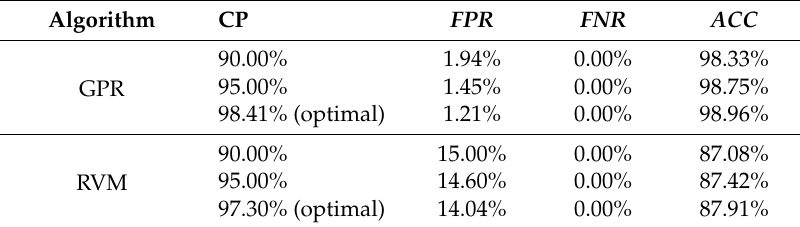
Figure 17. Anomaly detection for battery temperature series based on RVM model. Table 4. Anomaly detection with different